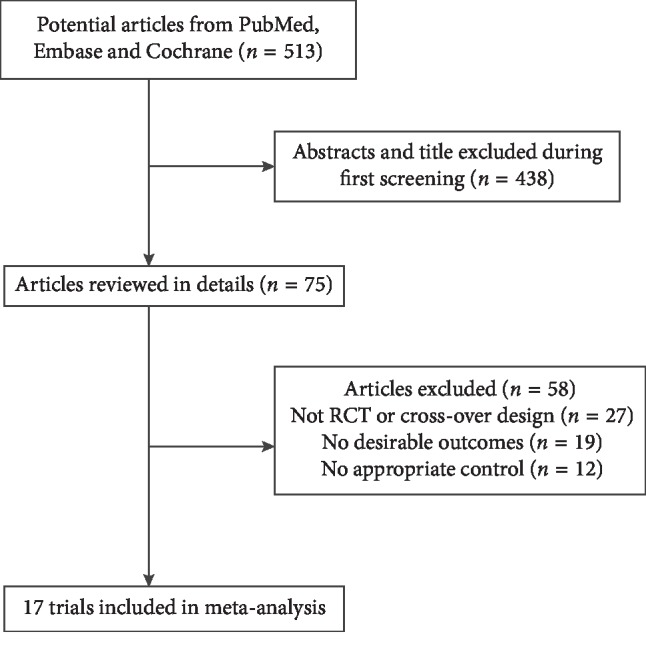
Flow chart of the study-selection process. Of the 513 hits retrieved in the initial database search, 438 were excluded by reviewing abstracts and titles, leaving 75 trials for assessment. After reviewing the full texts, 58 reports were excluded, and a total of 17 articles were included in this meta-analysis.